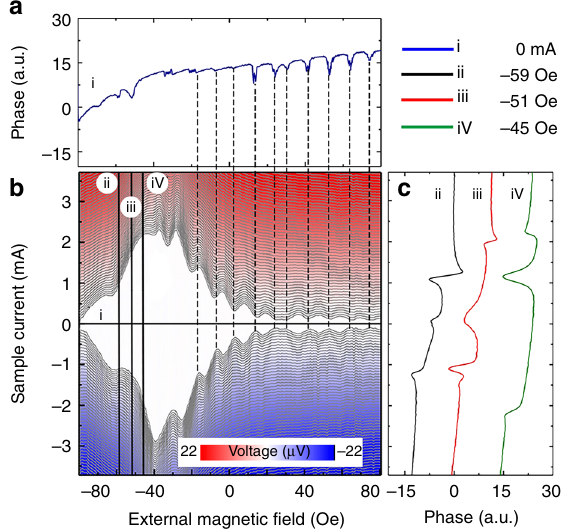
Fig. 4 Electronic properties of the device in the presence of the MFM tip 70 nm above the bottom edge of the junction. a Color-coded plot: the voltage drop across the junction measured as a function of applied current and external magnetic fi eld. Red (blue): positive (negative) voltage drop; white: zero-voltage drop (superconducting regions). b phase shift of the cantilever at zero current, corresponding to the cross-section (i) of the Fraunhofer pattern. Vertical dashed lines show correlations between the phase and the critical current. c phase vs current recorded at the magnetic fi elds − 59 Oe (black curve), − 51.4 Oe (red curve), and − 45.6 Oe (green curve). The curves correspond to the cross-sections (ii), (iii), and (iv) respectively of the Fraunhofer pattern. The phase drops positions correlate with the critical